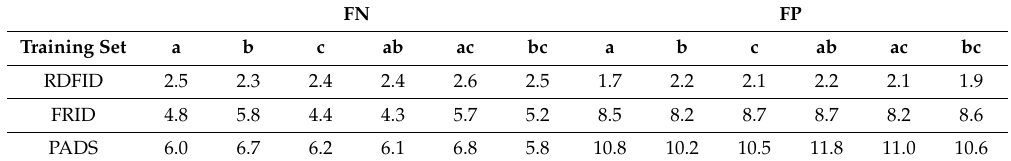
Table 2. False negative/false positive (FN/FP) of human detection in different scenarios (%). FN FP